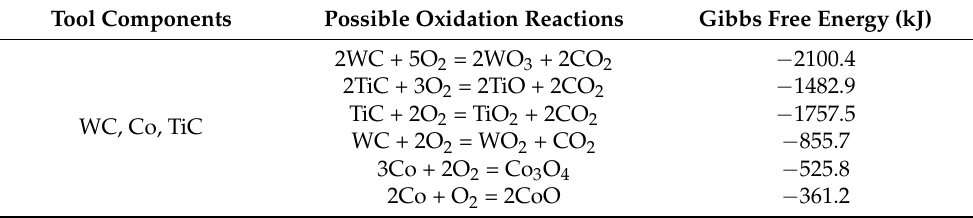
Table 4. Possible reactions with the oxidation products.